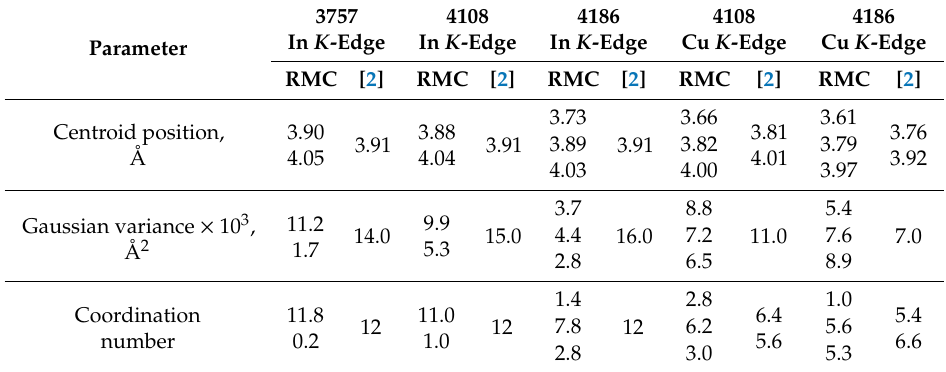
Figure 3. The RMC fit results of Cu K -edge EXAFS spectra for Samples 4108, and 4186 (doped with In and Cu). Panel A : experimental WT image; panel B : fitted WT image; panel C : calculated RDF for first three coordination shells around absorbing atom; panel D : experimental (black dotted line) and fitted (red solid line) EXAFS signal χ (k)*k 2 ; panel E : Fourier transform magnitudes of experimental (black dotted line) and fitted (red solid line) χ (k)*k 2 function; panel F : close view of Cu-Zn RDF. The RDFs fitted by Gaussians are shown by solid lines. Table 3. Structural parameters derived from Cu-Zn and In-Zn RDF decomposition. Results of the present study (RMC) are compared with values derived by conventional EXAFS analysis performed using IFFEFIT software